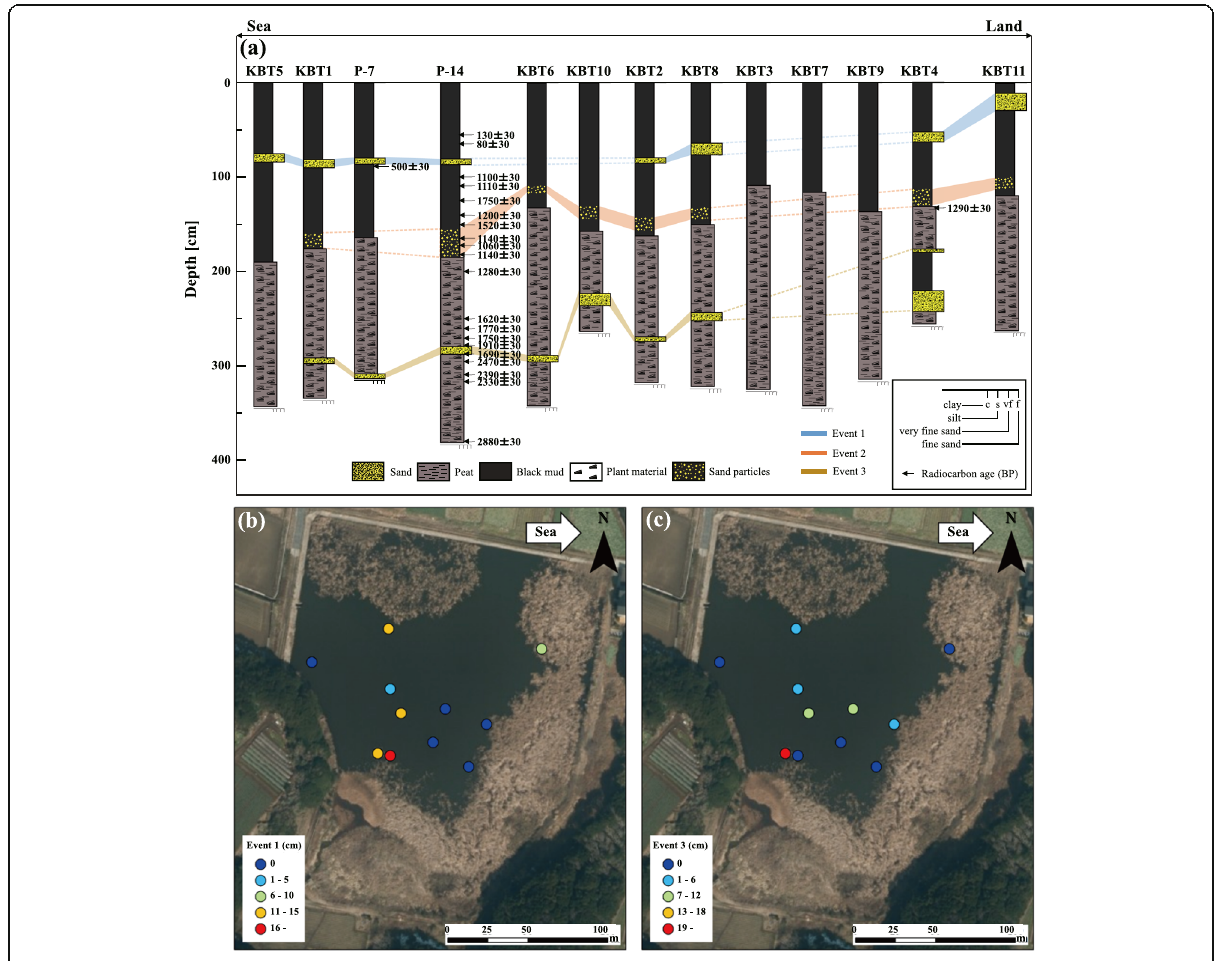
Fig. 2 a Stratigraphic correlation of the geological column of the cores in a sea-land direction. Satellite photographs show the thickness distribution of the b upper sand layer (event 1) and c lower sand layer (event 3) in this